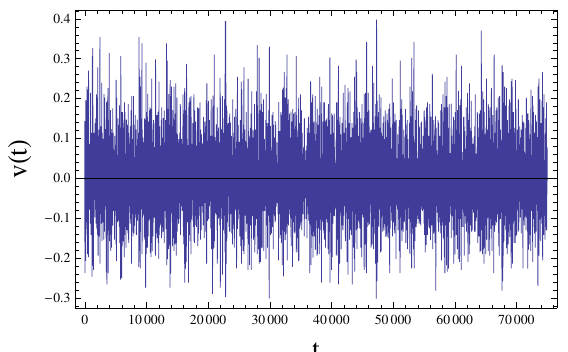
Figure 9. Time history of the voltage fluctuations v ( t ) .